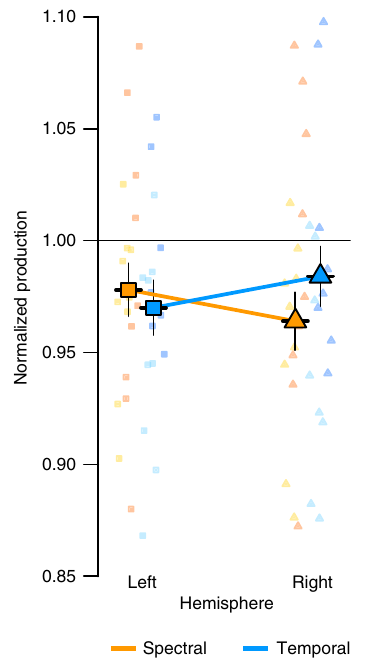
Fig. 2 Interaction between dichotic condition (left/right) and type of feedback alteration (spectral/temporal). Values represent produced speech features averaged across early and late ramp, hold and after effect phase separately for spectral (orange) and temporal (blue) feedback alterations presented to the left (square) and right (triangle) hemisphere, respectively. Produced speech features are relative to baseline, smaller values indicate greater compensation. Data present estimated means± model derived standard errors that account for between-subject variability ( n spectral = 18 participants, n temporal = 18). Individual raw values are plotted in the background (yellow: spectral perturbation vowel n = 9, orange: spectral perturbation consonant n = 9, light blue: temporal perturbation vowel n = 9, dark blue: temporal perturbation fricative n = 9). Source data are provided as a Source Data fi le.